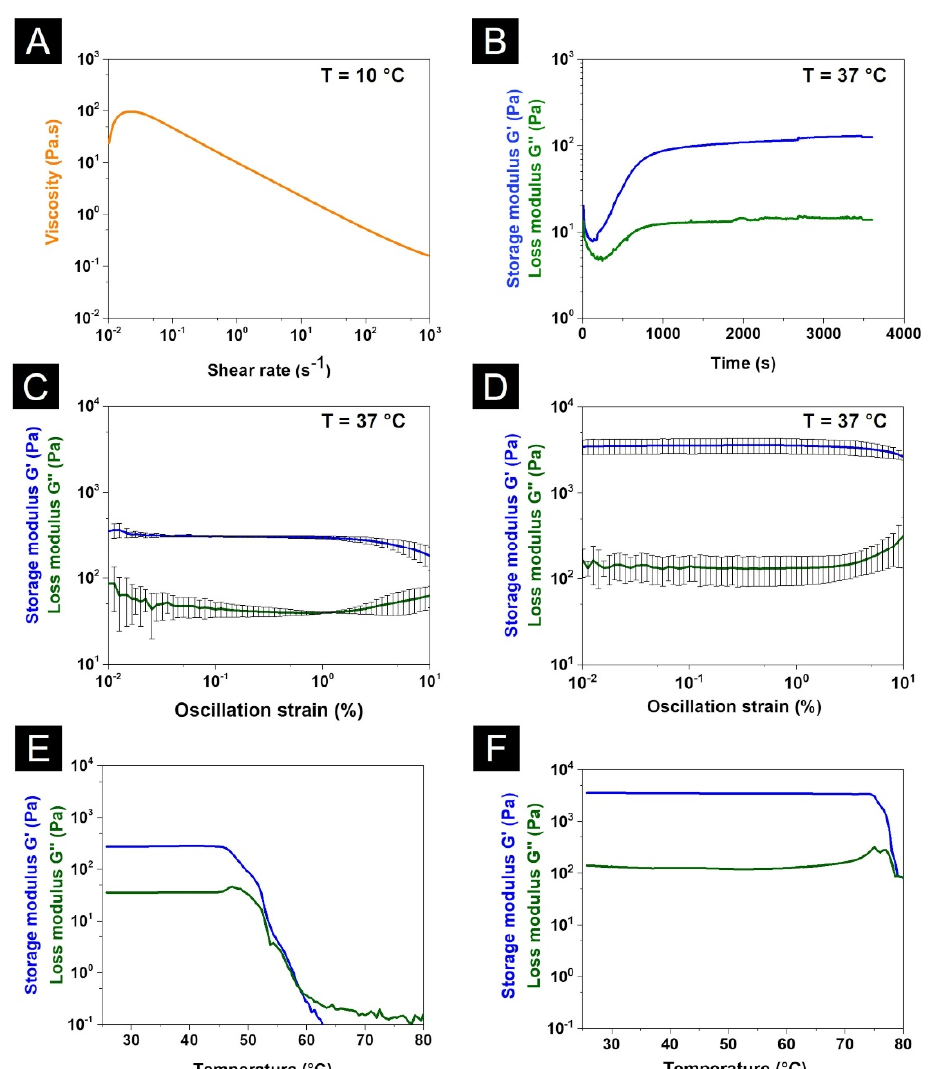
Figure 5. Rheological assessment of Coll/PLGA_TGF- β 1 system: flow ramp at 10 °C ( A ) and sol–gel transition at 37 °C ( B ) of the Coll/PLGA_TGF- β 1 system. Amplitude sweep tests at 37 °C ( C , D ) and temperature ramps ( E , F ) performed on Coll/PLGA_TGF- β 1 before ( C , E ) and after ( D , F ) the chemical crosslinking with genipin.